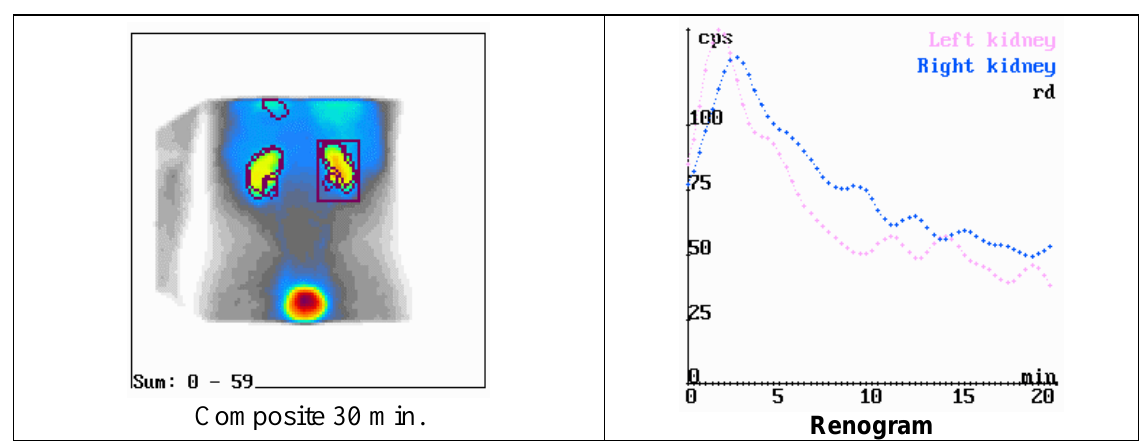
Figure 1A: Normal scintigraphy with diethylenetriamine penta-acetic acid labeled with technetium-99m ( 99m Tc-DTPA) (Patient 6).